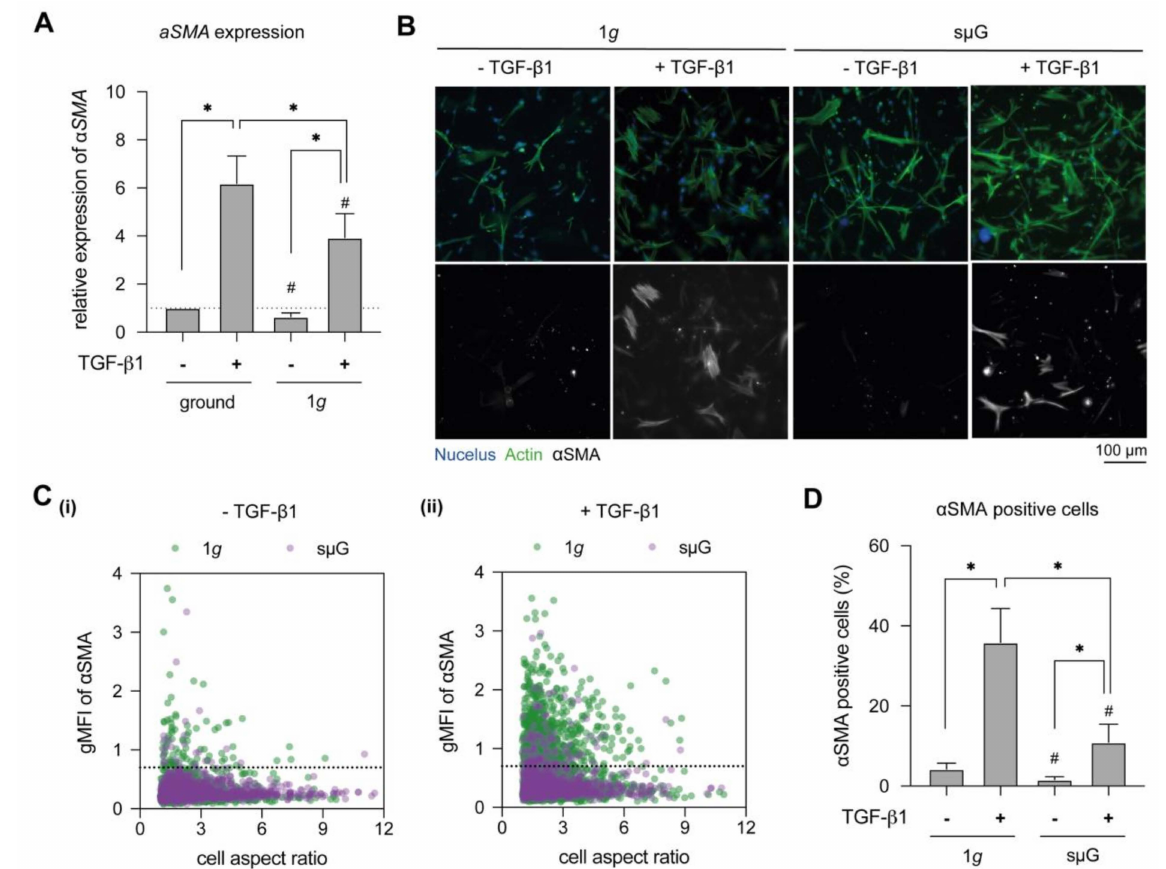
Figure 2. Myofibroblast differentiation in dependence of TGF- β 1 stimulation under 1 g and s µ G. Fibroblasts were cultured for 3 days in the presence and absence of TGF- β 1 under 1 g and s µ G conditions. ( A ) Cells were analyzed regarding α SMA expression using RT-qPCR. Gene expression analysis was performed in four replicates. ( B ) Representative image of fibroblasts stained with DAPI (blue), Phalloidin (green) and α SMA (grey) antibodies. ( C ) Quantitative analysis of geometric mean of fluorescence intensity (gMFI) of α SMA and cell aspect ratio using a custom-made image analysis toolbox. The dashed line in C(i) and C(ii) represents the cut-off value, below which are the majority of low α SMA expressing cells without TGF- β 1 under 1 g condition. ( D ) Percentage of α SMA positive cells. The image analysis was performed at least in triplicate with four positions per sample. Data are shown as mean +/ − SD. * indicates significant p ≤ 0.005. The character # represents the significance level of p ≤ 0.05 when compared to 1g at similar